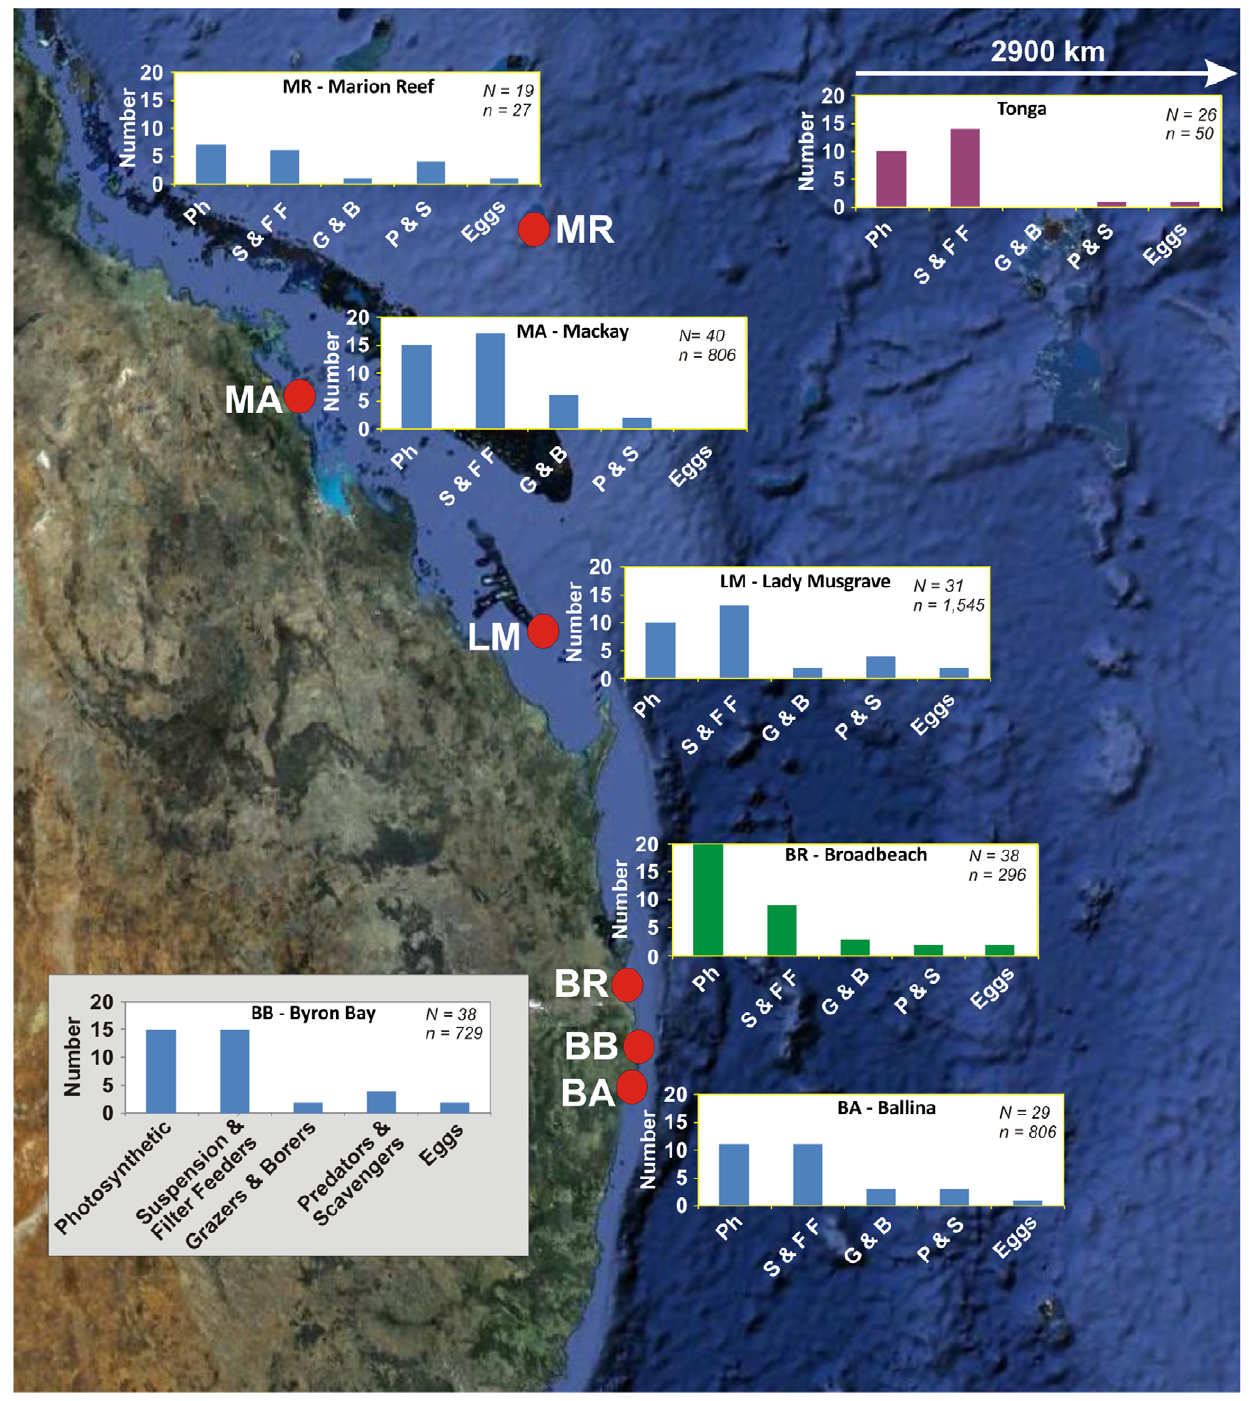
Figure 3. Proportions of rafted epibionts along the trajectory. Number refers to number of taxonomic units identified at each sample site. Marine invertebrates are grouped in terms of feeding behaviours. Suspension and filter feeders (e.g., cheilostome Bryozoa, goose barnacles, hydroids/ scyphozoans, serpulids, corals, molluscs, and oysters) show significant early recruitment (Tonga) with epibiont diversity generally maintained along the raft trajectory. The numbers of plants (cyanobacteria, macroalgae and calcareous algae) increased with time and along the trajectory, particularly once pumice had arrived into eastern Australian waters. Overall, epibiont diversity increased with time. Bar graphs are colour-coded with respect to observation/collection timing: purple, February 2007; blue, April-May 2007 and; green, December 2007. N is total number of species/taxonomic units observed, and n is number of pumice clasts described from each location. Abbreviations: Ph, photosynthetic; S & FF, suspension & filter feeders; G & B, grazers & borers; P & S, predators and scavengers. Locations: MR, Marion Reef; MA, Mackay; LM, Lady Musgrave; BR, Broadbeach; BB, Byron Bay; BA, Ballina. Tonga sample site occurs , 2900 km to the east. Base map from Google Earth.